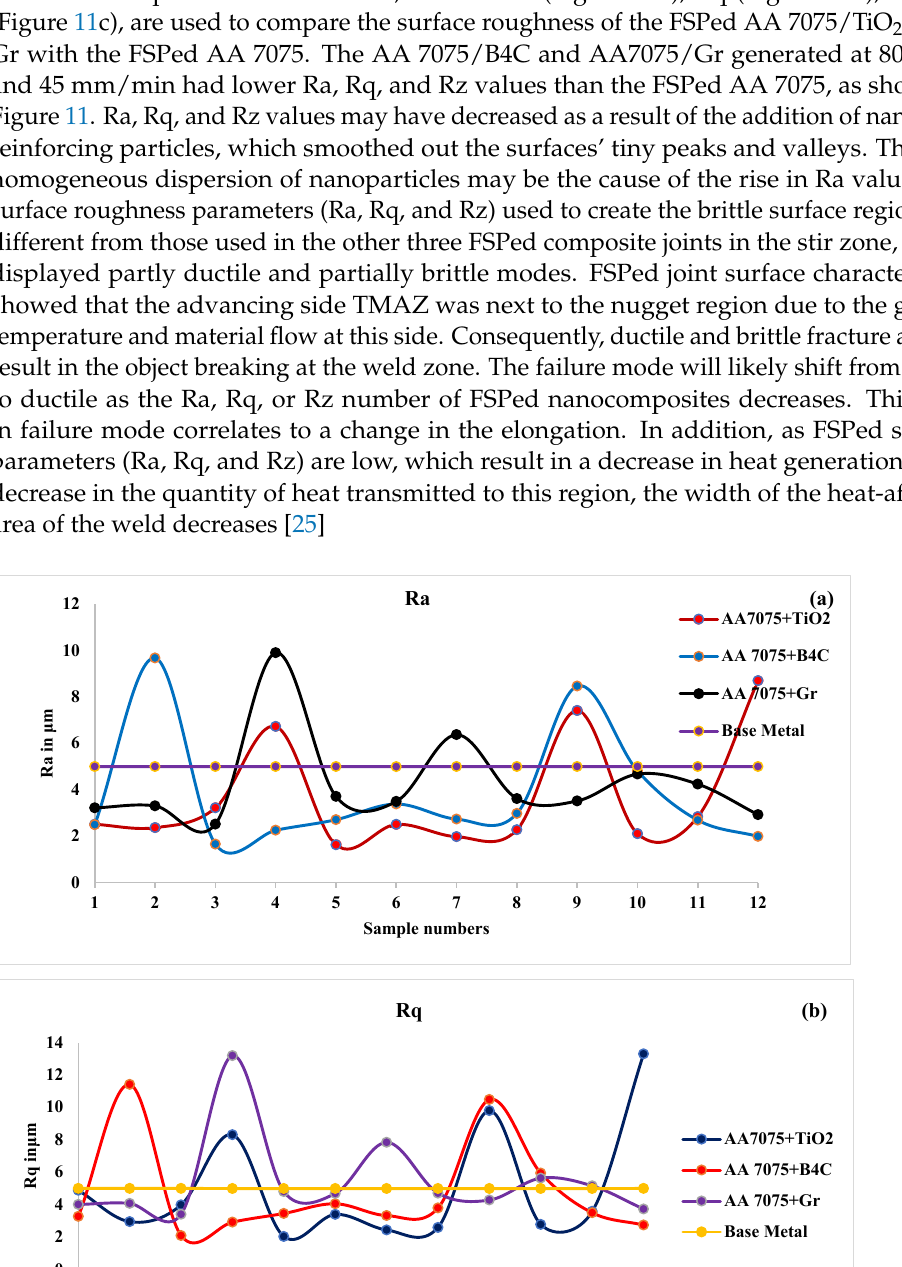
Figure 10. Surface roughness in terms of ( a ) Ra, ( b ) Rq and ( c ) Rz of FSPed AA 7075/TiO 2 / B 4 C/Gr produced by selected processing parameters as compared to FSPed AA7075. 4. Conclusions This study examined the impact of different nanoparticles on the micro-hardness, surface roughness and SEM morphology of various surface composites. Results showed that when compared to base material and FSPed samples at 800 and 1400 rpm, the TiO 2 and AA 7075 substrate produced at 1400 rpm had satisfactory bonding and had the most homogeneous TiO 2 dispersion and the largest grain-reduced size. The micro-hardness val- ues for the surface composite consisting of AA 7075/B 4 C at 1200 rpm were 101 Hv and 147. 4 Hv, respectively. A micro structural study revealed that homogeneous distribution of particles was achieved at a 1200 rpm rotating speed. The surface micro-hardness was 46% (with Gr), 54.5% (with B 4 C) and 48% (with TiO 2 ) higher than the substrate material. The produced composite with the highest hardness was the AA7075/B 4 C surface composite. Thus, hybrid composites may be created to enhance the necessary qualities of aluminum surface composites with the inclusion of transmission electron microscopy investigations. Altering the tool profile allows the use of various methods, such as finite element analysis, for the same investigation. Author Contributions: Conceptualization, M.M.H. and S.Y.; methodology, M.M.H.; software, MMH.; validation, M.M.H., S.Y.; formal analysis, M.M.H.; investigation, M.M.H.; resources,